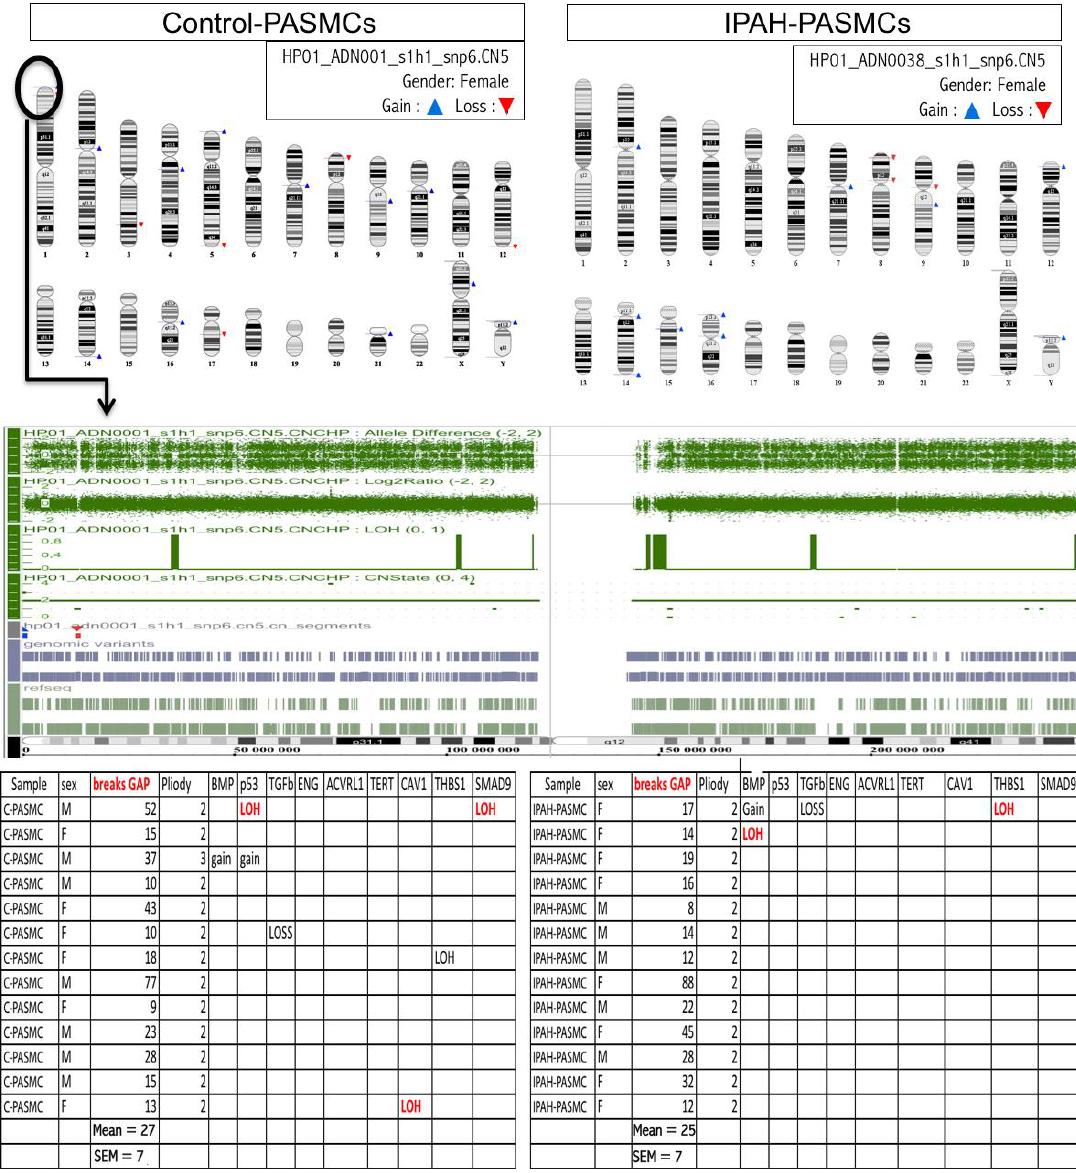
Figure 5. Genomic stability in IPAH. ( Upper panel ) Representative comparative genomic hybridization (CGH) array showing the gain, loss, and location of DNA regions on each chromosome. ( Lower panel ) The number of break-points in ten controls (C-PASMCs) and ten patients with IPAH (IPAH-PASMCs) as well as the gain, loss, and loss of heterozygosity (LOH) in all genomic DNA regions; this was done by focusing on regions encoding genes identified to be involved in the development of IPAH.